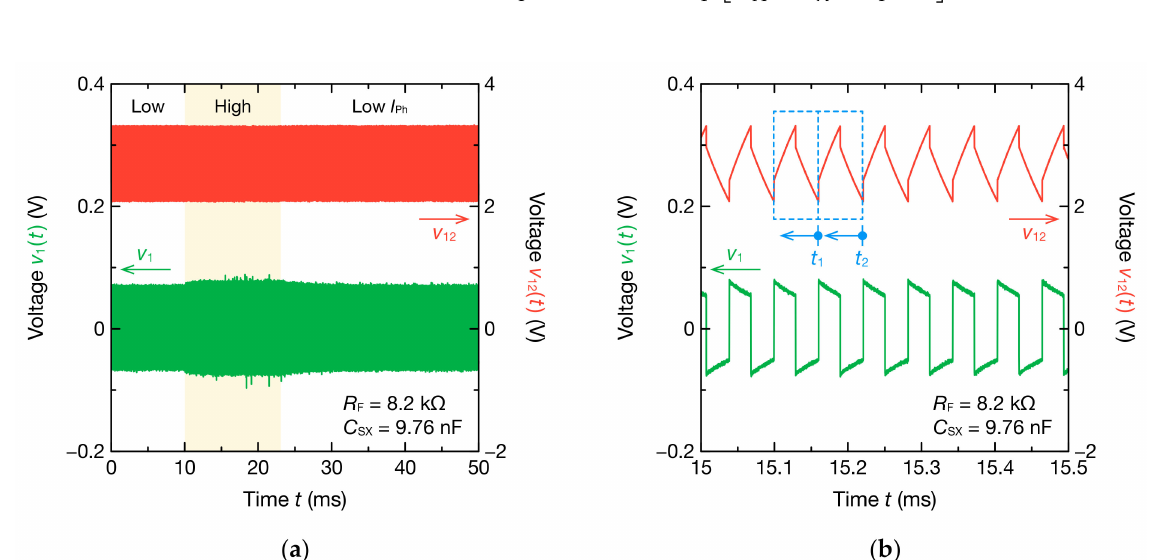
Figure 17. Single-mode oscillation waveforms of v 12 ( t ) and v 1 ( t ) for the nonsinusoidal oscillator incorporating the CdS photocell (Figure 3a): ( a ) full waveform and ( b ) enlarged waveform. The photocurrent I Ph of the photocoupler is changed at 10 and 23 ms. The high and low levels of I Ph are 2.0 and 0.6 mA, respectively. Circuit parameters are estimated for each cycle (blue dashed line). Representative points of time in each cycle are the ends of the cycles such as t 1 and t 2